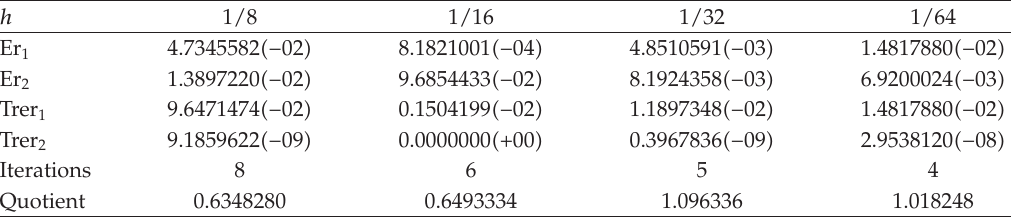
Table 4: Results on the square with a posteriori estimates as a stopping criteria for the second example.